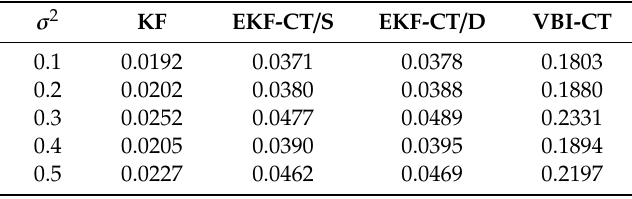
Table 6. Total execution time (s) of di ff erent algorithms.